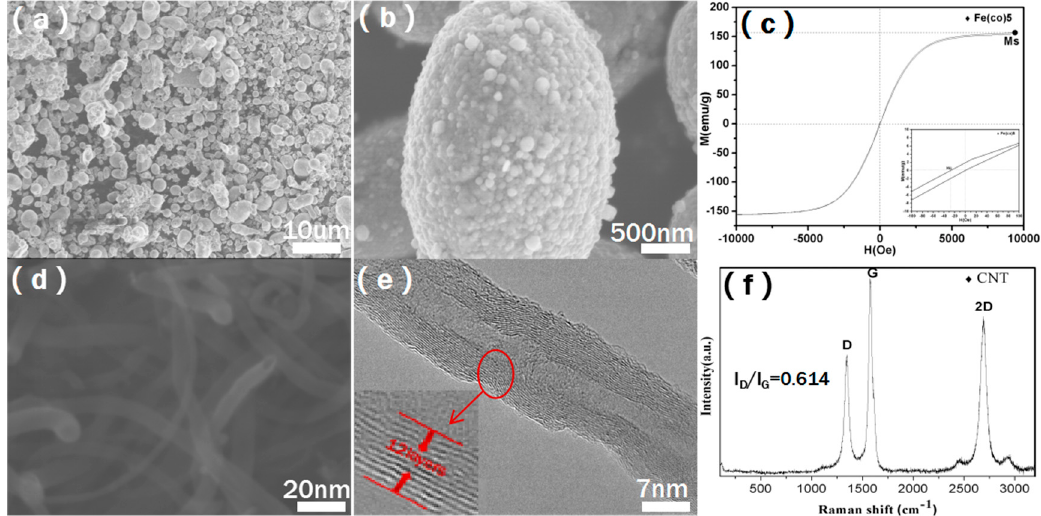
Figure 1. SEM images ( a , b ) of the carbonyl iron powders (CIPs); VSM image ( c ) of the CIPs; SEM images ( d , e ) of the carbon nanotubes (CNTs); the Raman image ( f ) of the CNTs.